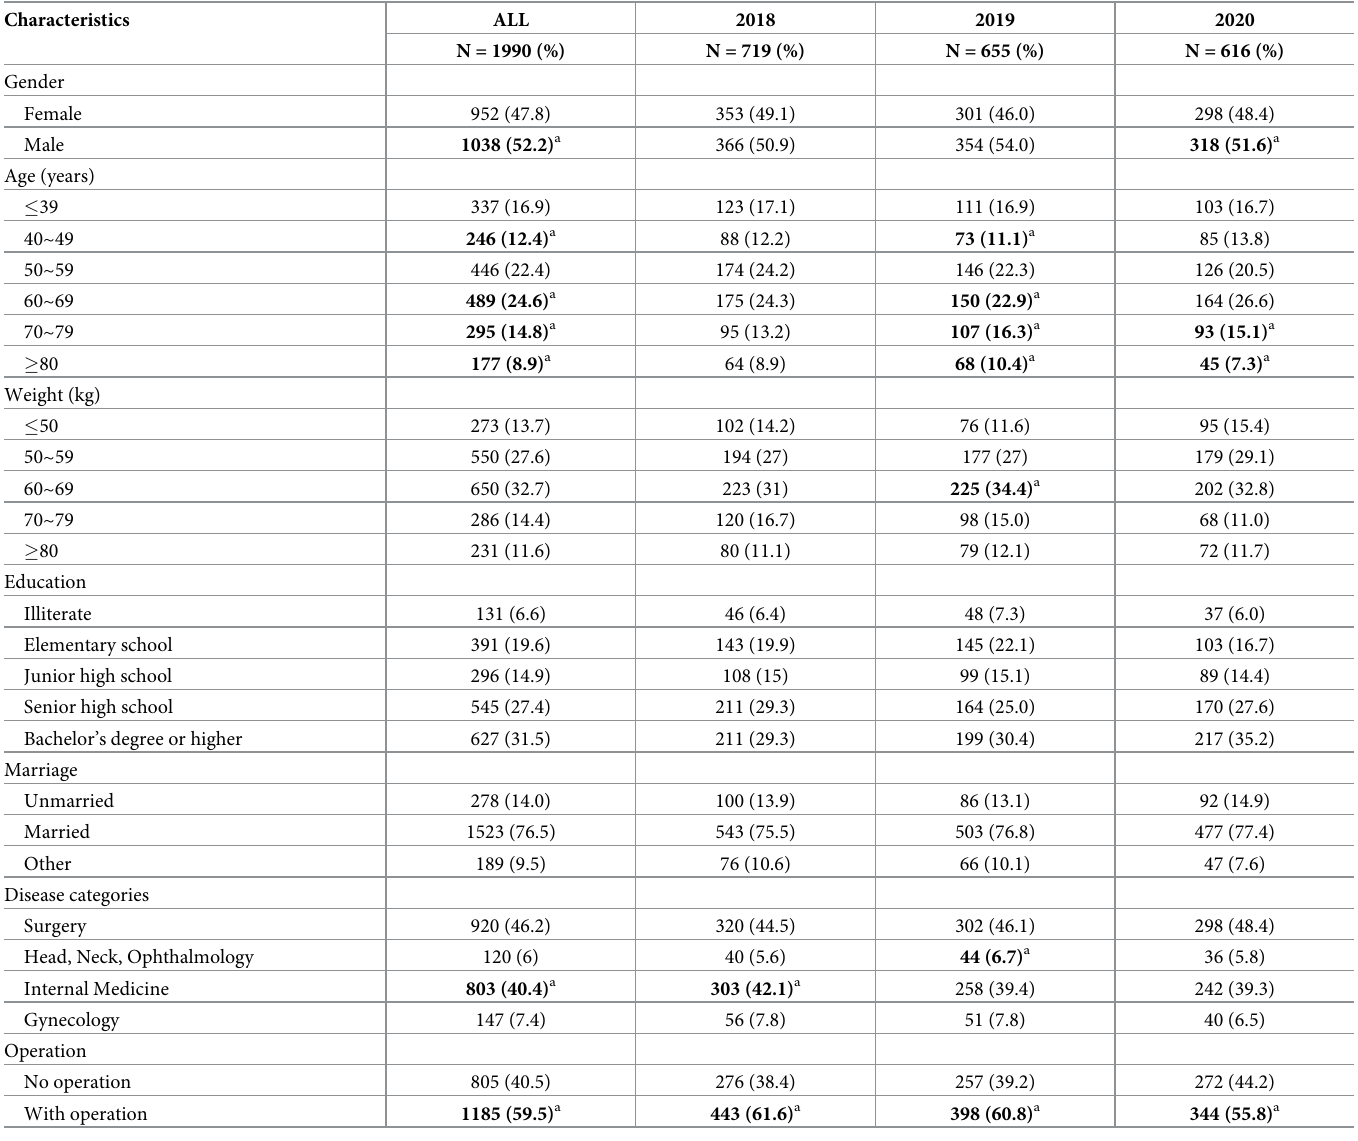
Table 2. The changes of risk factor among the patients with pain from 2018 to 2020.